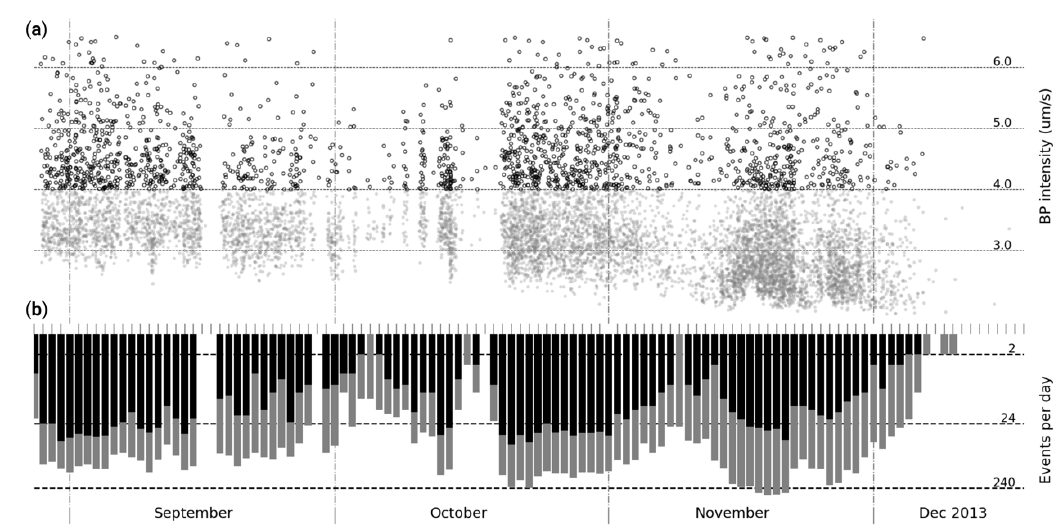
Figure 6. BP-based catalog of high-energy events (in black, correspond to Figure 4c) and indistinct detections (in grey, correspond to Figure 4b): ( a ) intensity and ( b ) daily rate of detection during the chosen period.